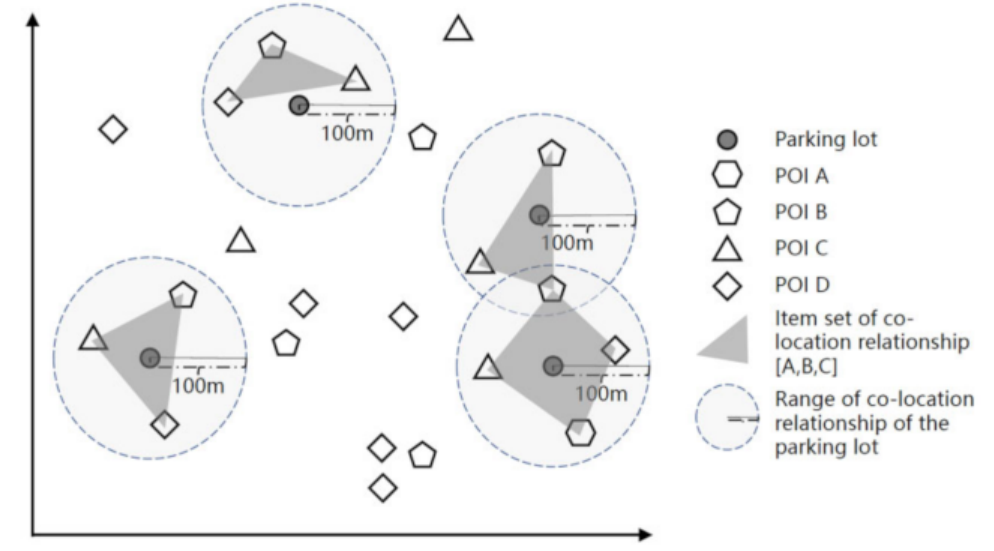
Figure 5. The co-location relationships of parking spaces and